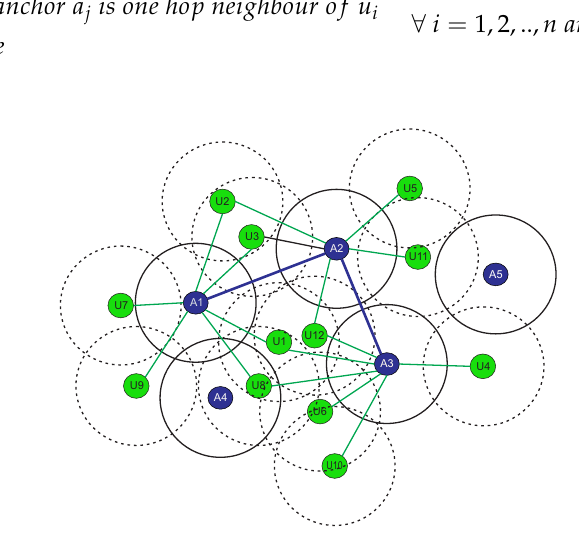
Figure 1. Example